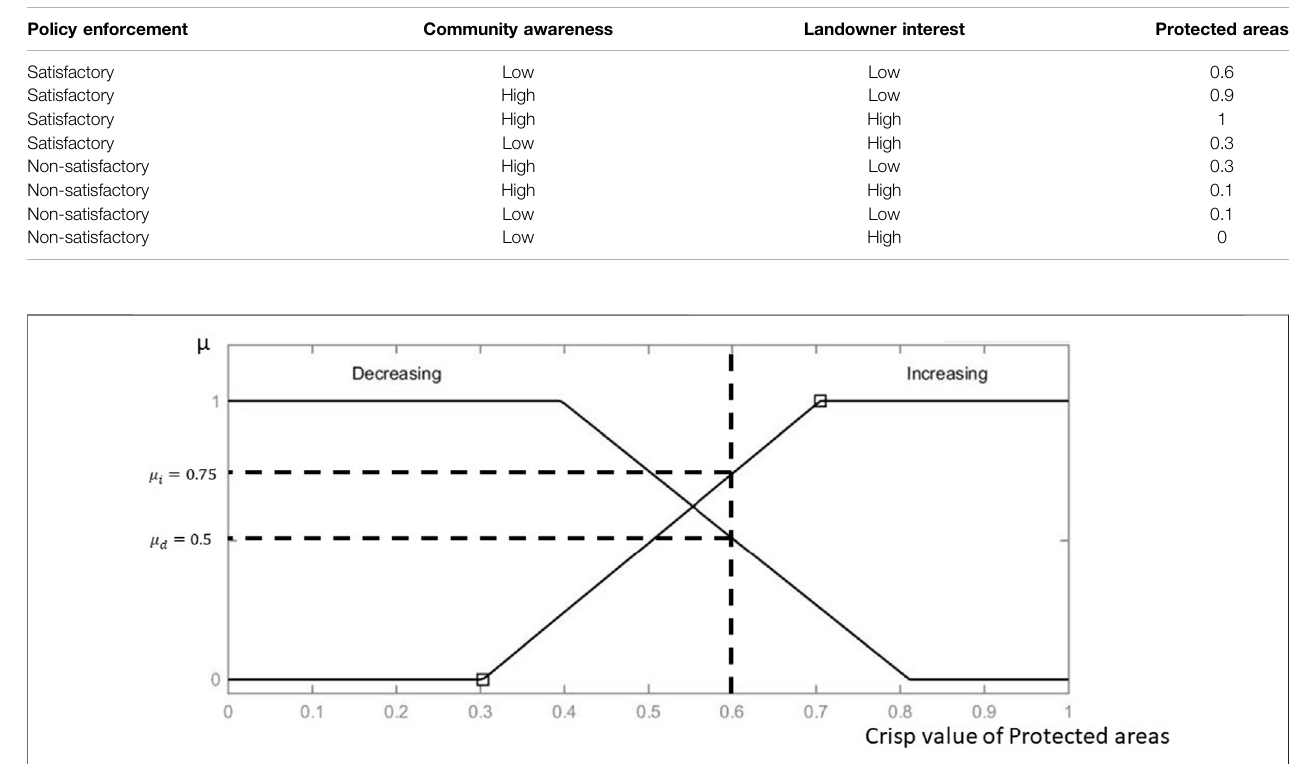
FIGURE 6 | Membership degree assessment for the crisp value 0.6 of the variable “ Protected areas. ”